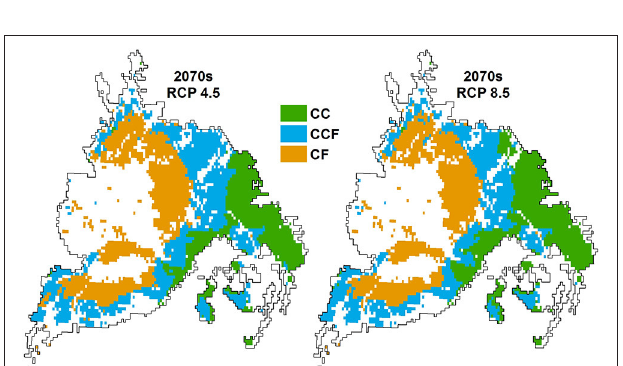
FIGURE 5 | Distribution of agroecological classes in the dryland region of the Inland Pacific Northwest (crop/fallow (CF), annual crop/fallow transition (CCF) and continuous cropping (CC)), projected for the 2070s and based on the average of results from 12 global climate models under 2 representative concentration pathways (RCP), 4.5 and 8.5.